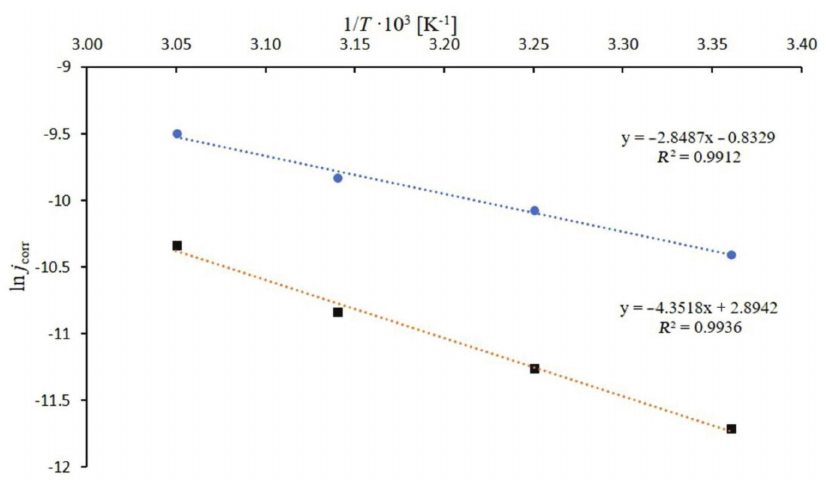
Fig. 5 – Arrhenius’s plots for Cu in 0.51 mol dm –3 NaCl: in the absence (●), and in presence of propolis extract (■) in concentration of 3500 mg dm –3